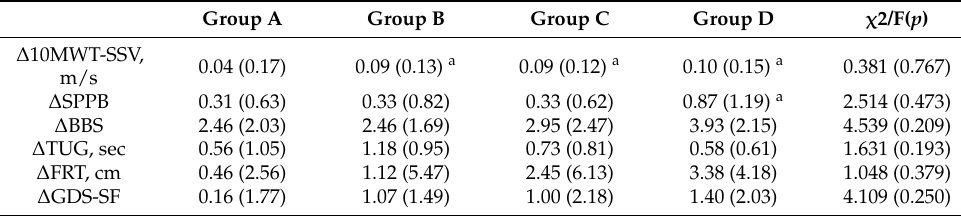
Table 2. Pre–Post Change and MCID in Physical Function and Depression ( N = 58).